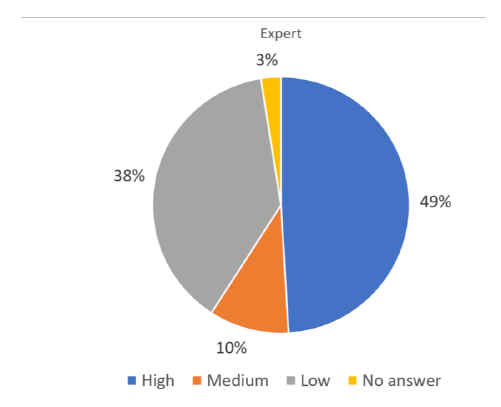
Figure 5. Geolocation Precision Examples